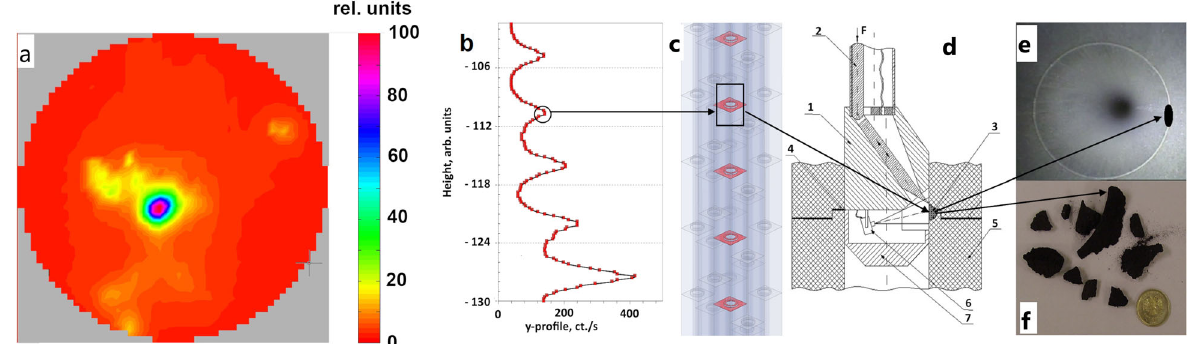
Fig. 1 Spatial distribution of “ hot ” spots due to fuel debris in the reactor pile and sampling device. A Neutron emission map in horizontal plane of the reactor stack, diameter of the stack is ~9 m. B , C Typical vertical γ -pro fi le along technological channel, maxima of γ -activity correspond to joints between graphite blocks. D The sampling device: 1 — body, 2 — movable rod allowing chisel operations, 3 — chisel contact with a contaminated area, 4 — joint between graphite blocks, 5 — graphite block, 6 — videocamera, 7 — sample collector. E Camera view of the channel walls with a joint between the graphite blocks. F Pieces of graphite extracted from the damaged channel (the coin diameter is 22 mm).